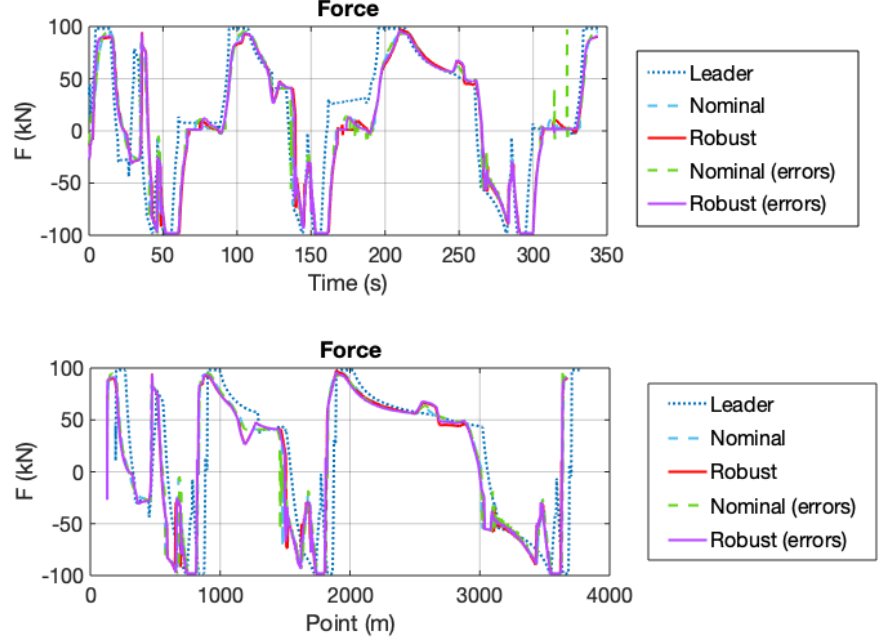
Figure 8. Results of simulation 2: errors in the preceding train information. Force vs. time.